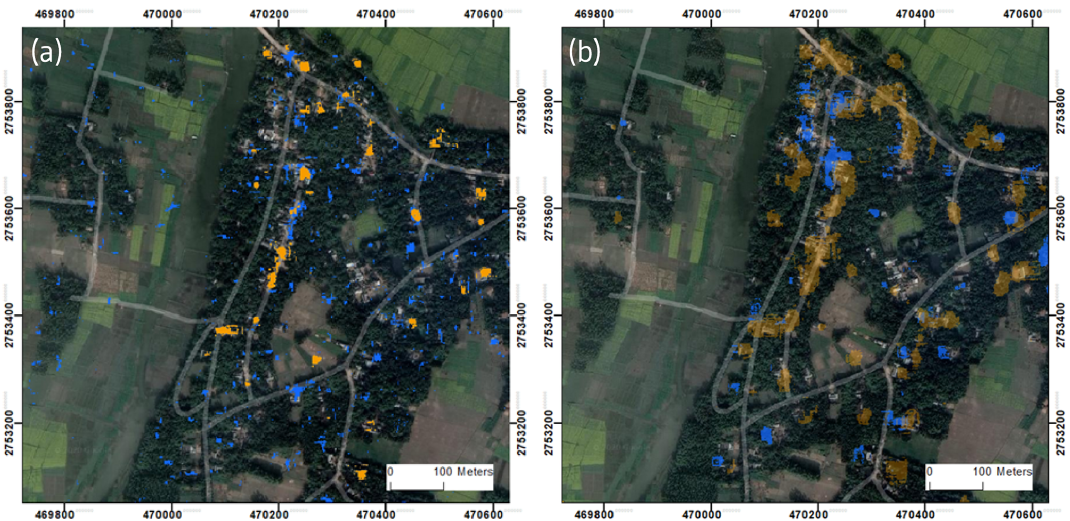
Figure A5. (a) Classification of settlements using the dispersion index only (blue) or the combination of dispersion index and amplitude threshold (orange). Thresholds: 0.25 (dispersion index); − 2dB (amplitude). (b) Settlement detection for ascending (orange) and descending (blue) orbit. Thresholds: 0.4 (dispersion index); − 4dB (amplitude). Sampling duration for both panels: 6 months. The location of the patch is shown in Fig. A1 (patch 2). Source of optical background image: Google, ©2020 Maxar Technologies, CNES/Airbus.